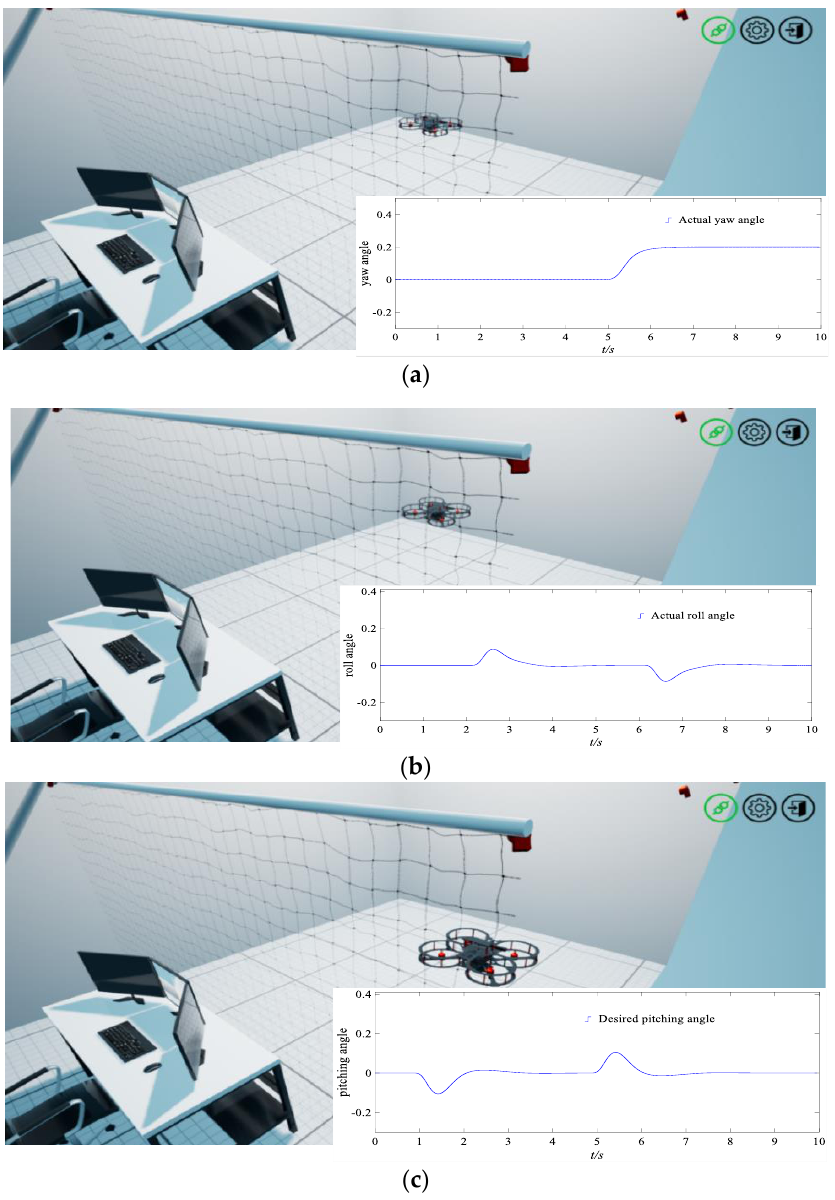
Figure 6. Flight simulation experiments of a quadrotor UAV and the tracking curves of yaw angle, roll angle, and pitching angle. ( a ) The initial stage of the quadrotor UAV and tracking responses of an actual yaw angle . ( b ) The quadrotor UAV in flight, and the tracking responses of an actual roll angle. ( c ) The final stage approaching the target, and tracking responses of an actual pitching angle .